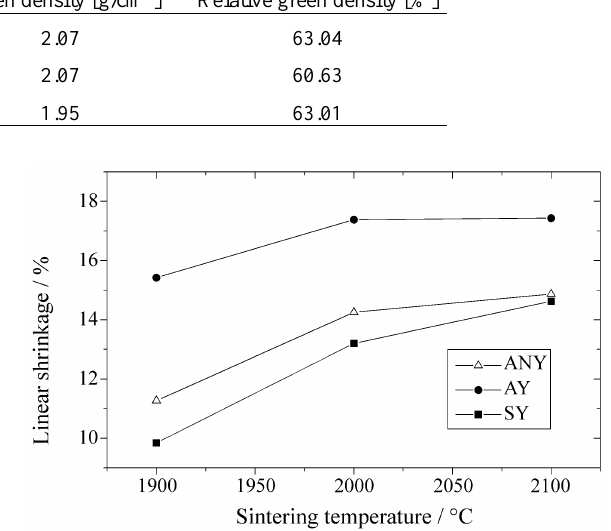
Figure 3. Linear shrinkage of the samples vs. sintering